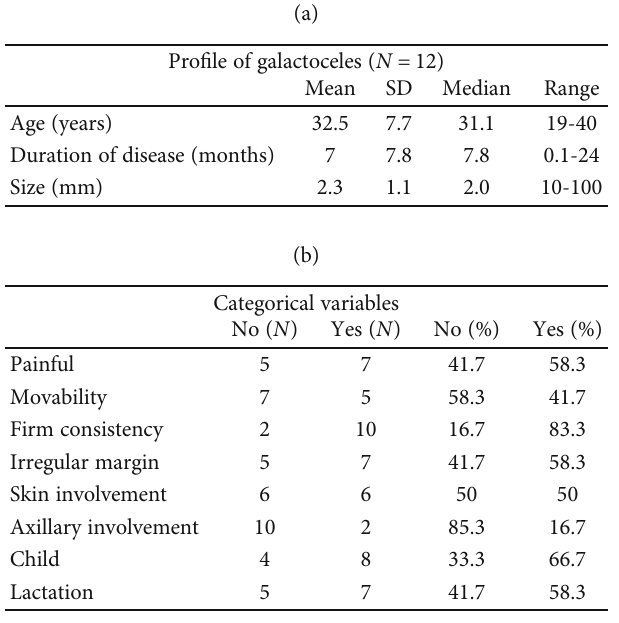
Table 5: Context variables for galactoceles.